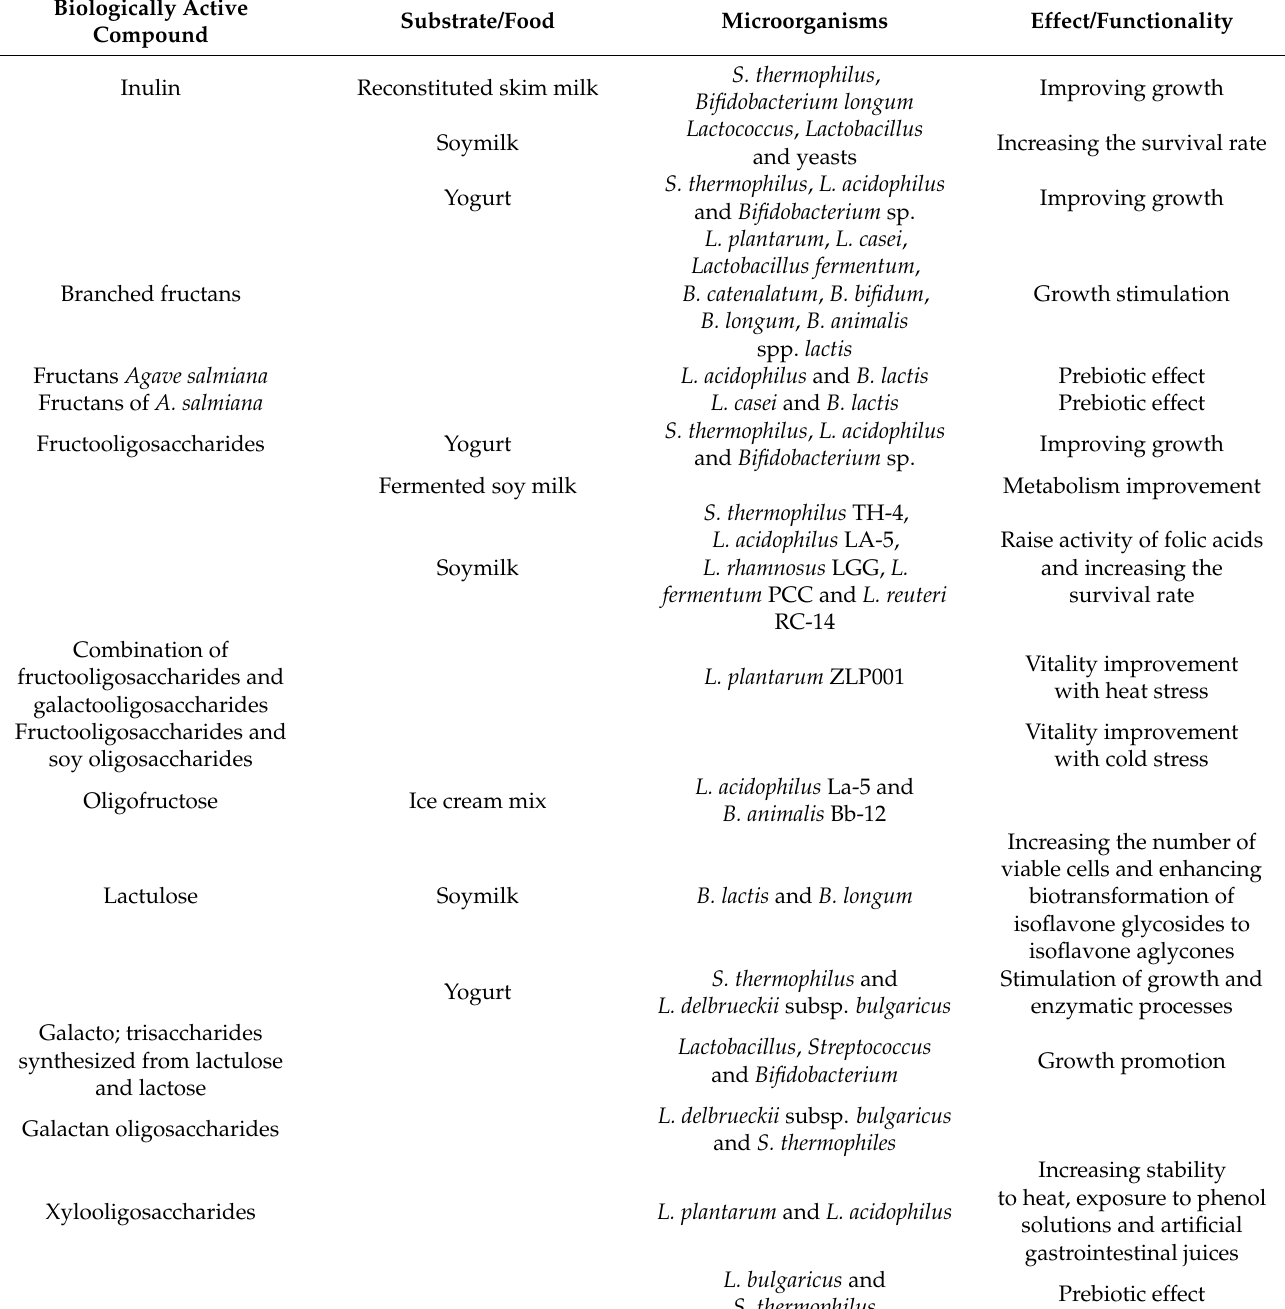
Table 1. The most notable poly-/oligosaccharide bioactive